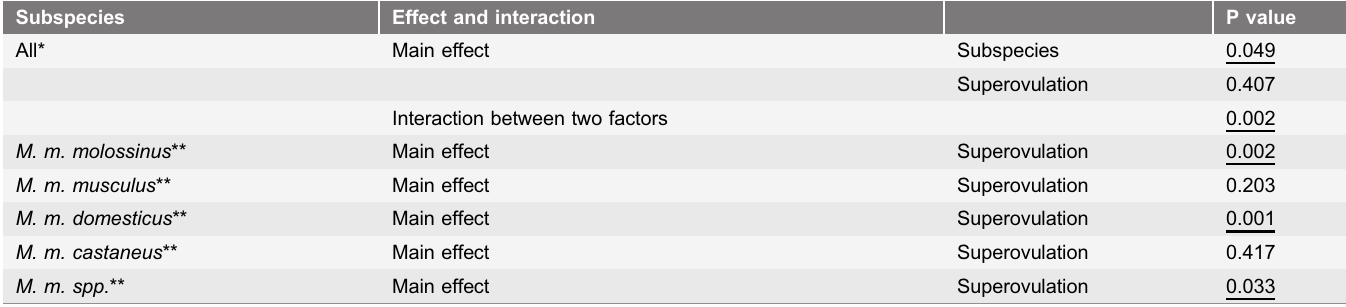
Table 2. Probabilities (P values) of main effects on the number of ovulated oocytes and their interactions.